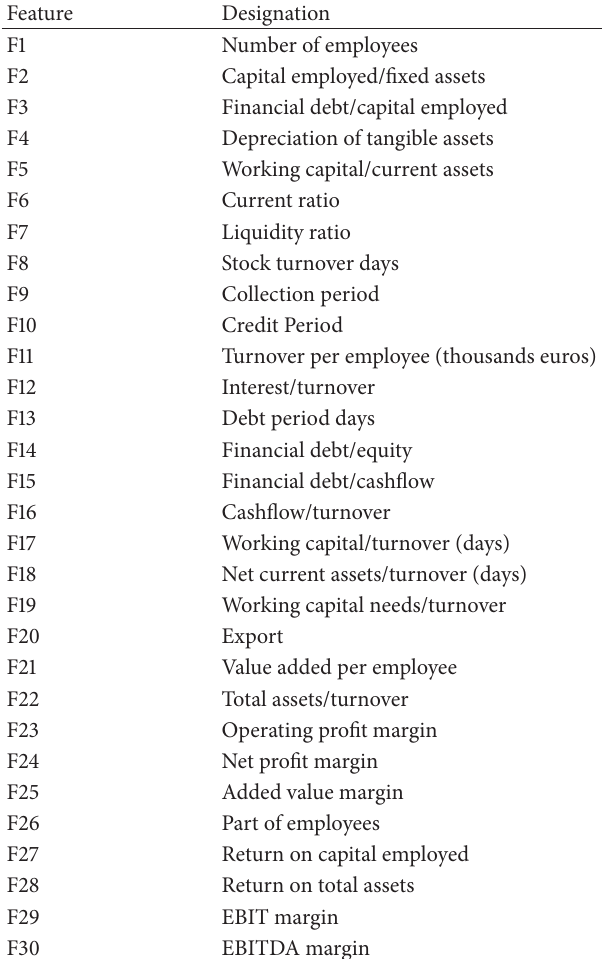
Table 1: Set of features considered for the industrial French com-